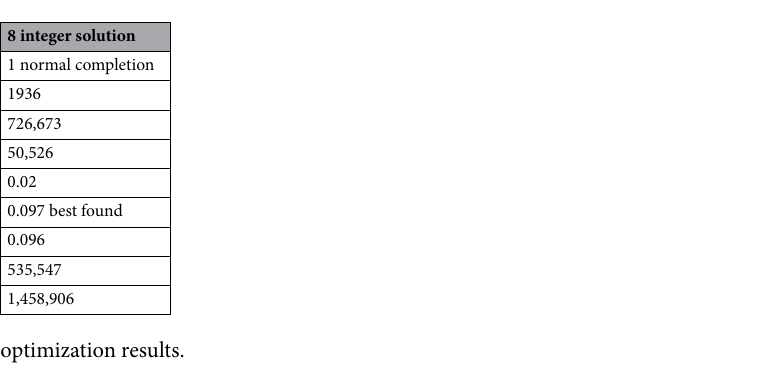
Table 6. Proposed MILP optimization